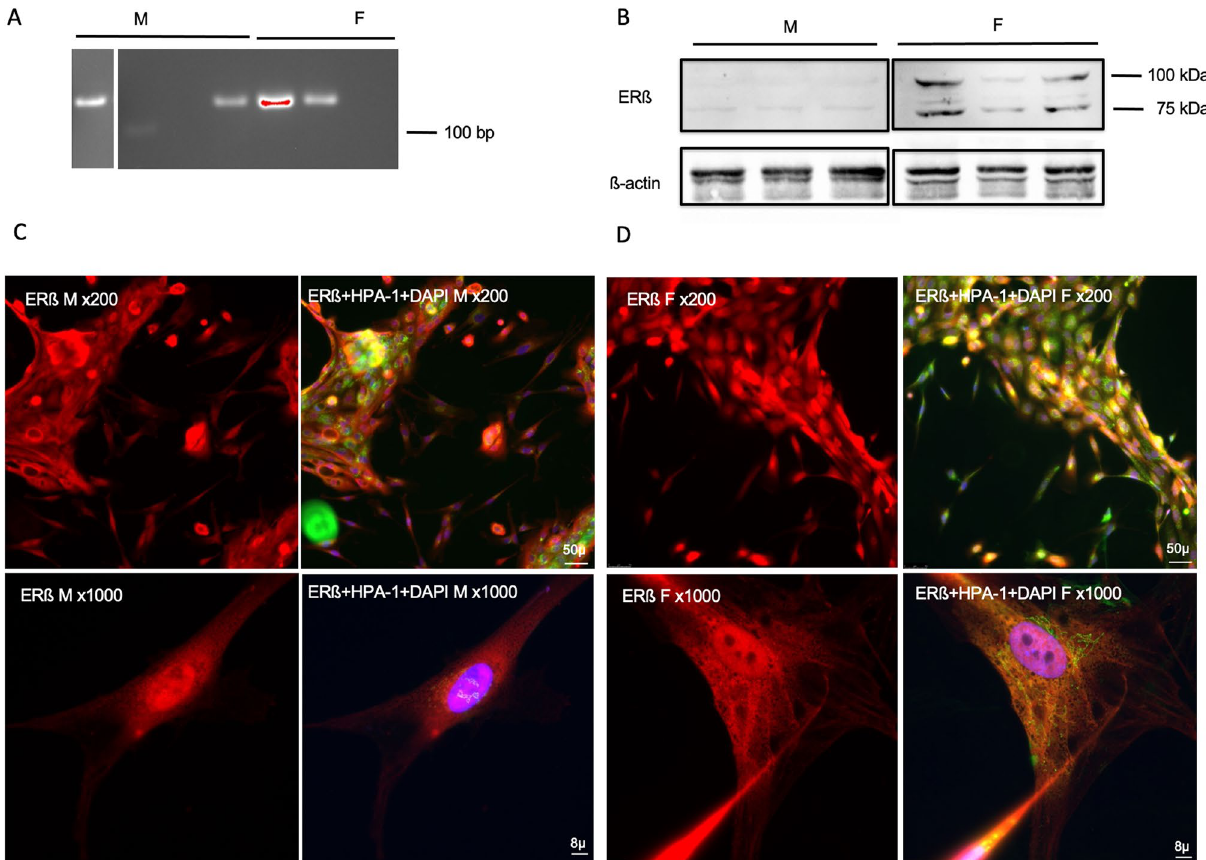
Figure 2. Identification of ERβ in human conjunctival goblet cells cultured from males and females. RNA was isolated from cultured goblet cells and RT-PCR performed using primers for human Erβ . A single band was detected at around 100 bp in 2 out of 4 samples from males (M) and 2 out of 3 samples from females (F) ( A ). Protein samples were collected from cell pellets and Western Blot analysis was performed using antibody against ERβ. Two bands at 100 and 75 kDa respectively were detected in female samples ( B ). Trace immunoreactivity of the same size as in females was present in male samples ( B ). Immunofluorescence microscopy was performed on cultured goblet cells using antibodies to ERβ ( C and D ). ( C ) indicate immunofluorescence to ERβ (red) in male cells; ( D ) indicate immunofluorescence to ERα (red) in female cells; an overlay of anti-ERβ, HPA-1 (green, indicates the secretory granules of goblet cells), and DAPI (blue, indicates cell nuclei) is shown next to the single channel image of ERβ. Magnification was × 200 in the upper panels; × 1000 in the lower panels. Original blots/ gels are presented in Supplementary Figs. 5 and